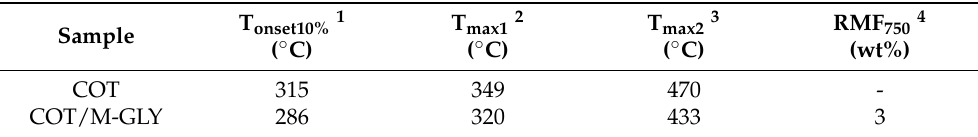
Figure 1. TG ( a ) and dTG ( b ) curves of untreated and 4% add ‐ on treated cotton (COT/M ‐ GLY) in air. Heating rate: 10 °C min − 1 . Table 1. Thermal data by thermogravimetric analysis of untreated (COT) and M ‐ GLY ‐ treated (COT/M ‐ GLY) cotton in air.